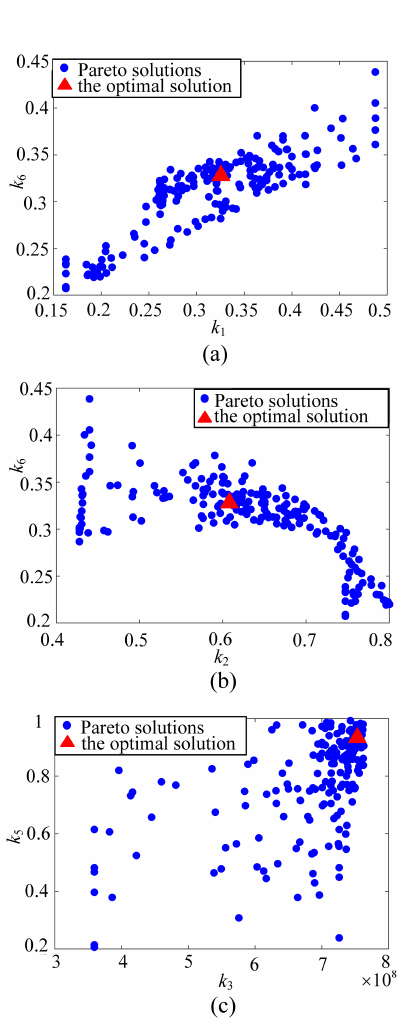
Figure 8. Pareto solutions and the optimal